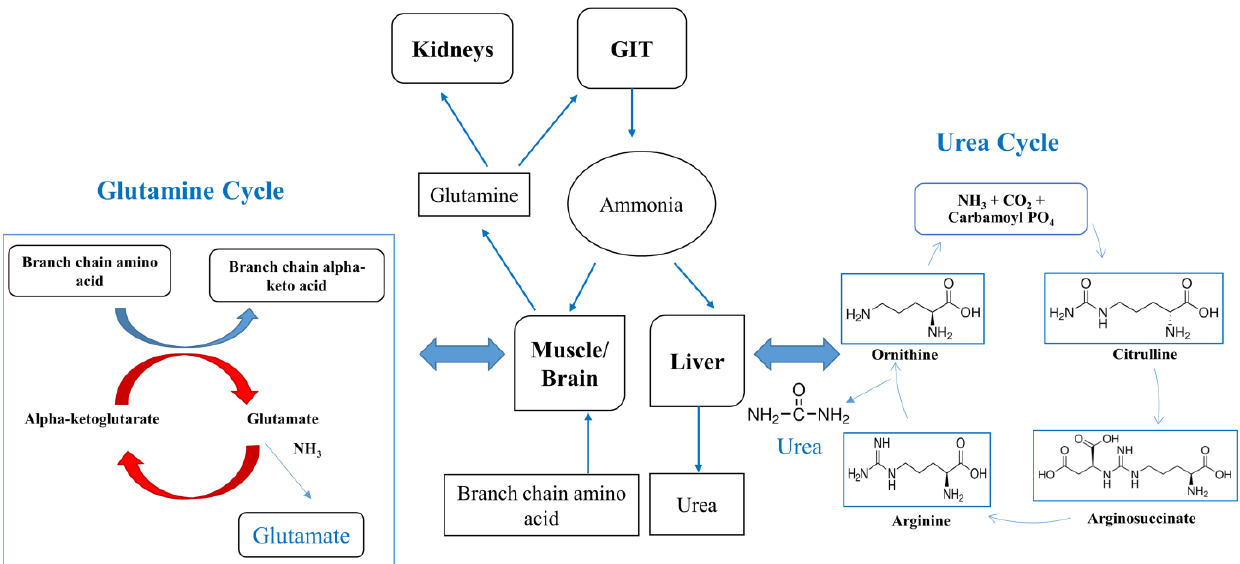
Figure 1. Outline of Ammonia Metabolism by Urea and Glutamine cycles in the Human body. The -glutamine cycle is a metabolic pathway that describes the formation of glutamate (reversible reaction-red arrow) from α-ketoglutarate carried out by glutamate synthetase, while branch chain amino acids are converted to branch chain α-keto acid by branch chain dehydrogenase enzyme.